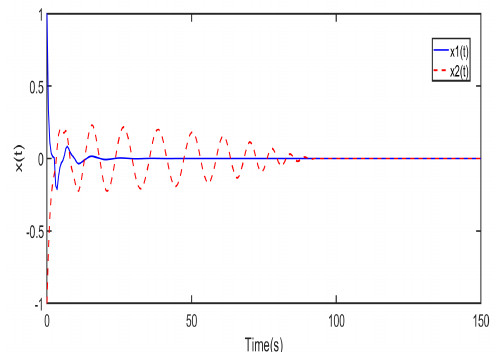
Figure 1. The trajectories of the system states in Ex1.